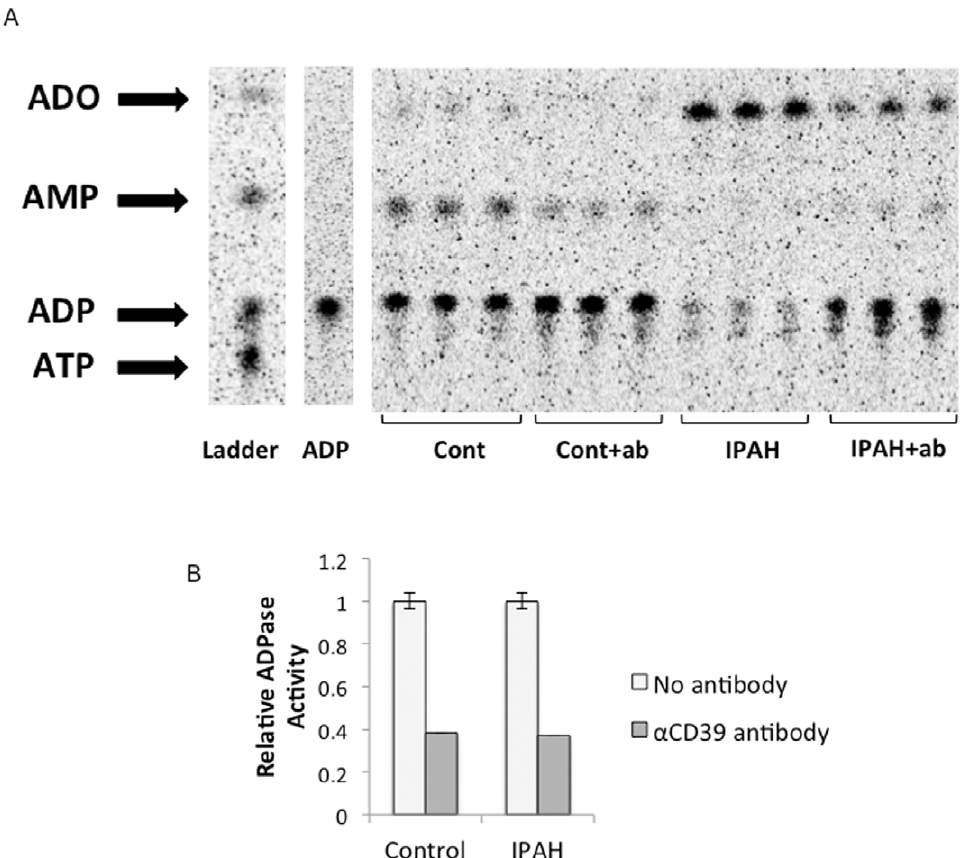
Figure 7. Microparticle ADPase inhibition using anti-CD39 monoclonal antibody. ( A ) TLC performed following anti-CD39 pre-treatment of microparticles from healthy controls and IPAH patients ( Cont + ab and IPAH + ab ) shows a decrease in the dephosphorylation of 14C ADP to AMP and adenosine (ADO) in both groups compared to samples without antibody pre-treatment ( Cont and IPAH ). The ADP lane contains 14C ADP subjected to the same experimental conditions but without microparticles. Quantification of the percent of available 14C ADP converted to AMP and ADO ( B ) reveals a relative decrease in nucleotidase activity of 62% in controls and 63% in IPAH patients (normalized to samples not pre-treated with antibody).